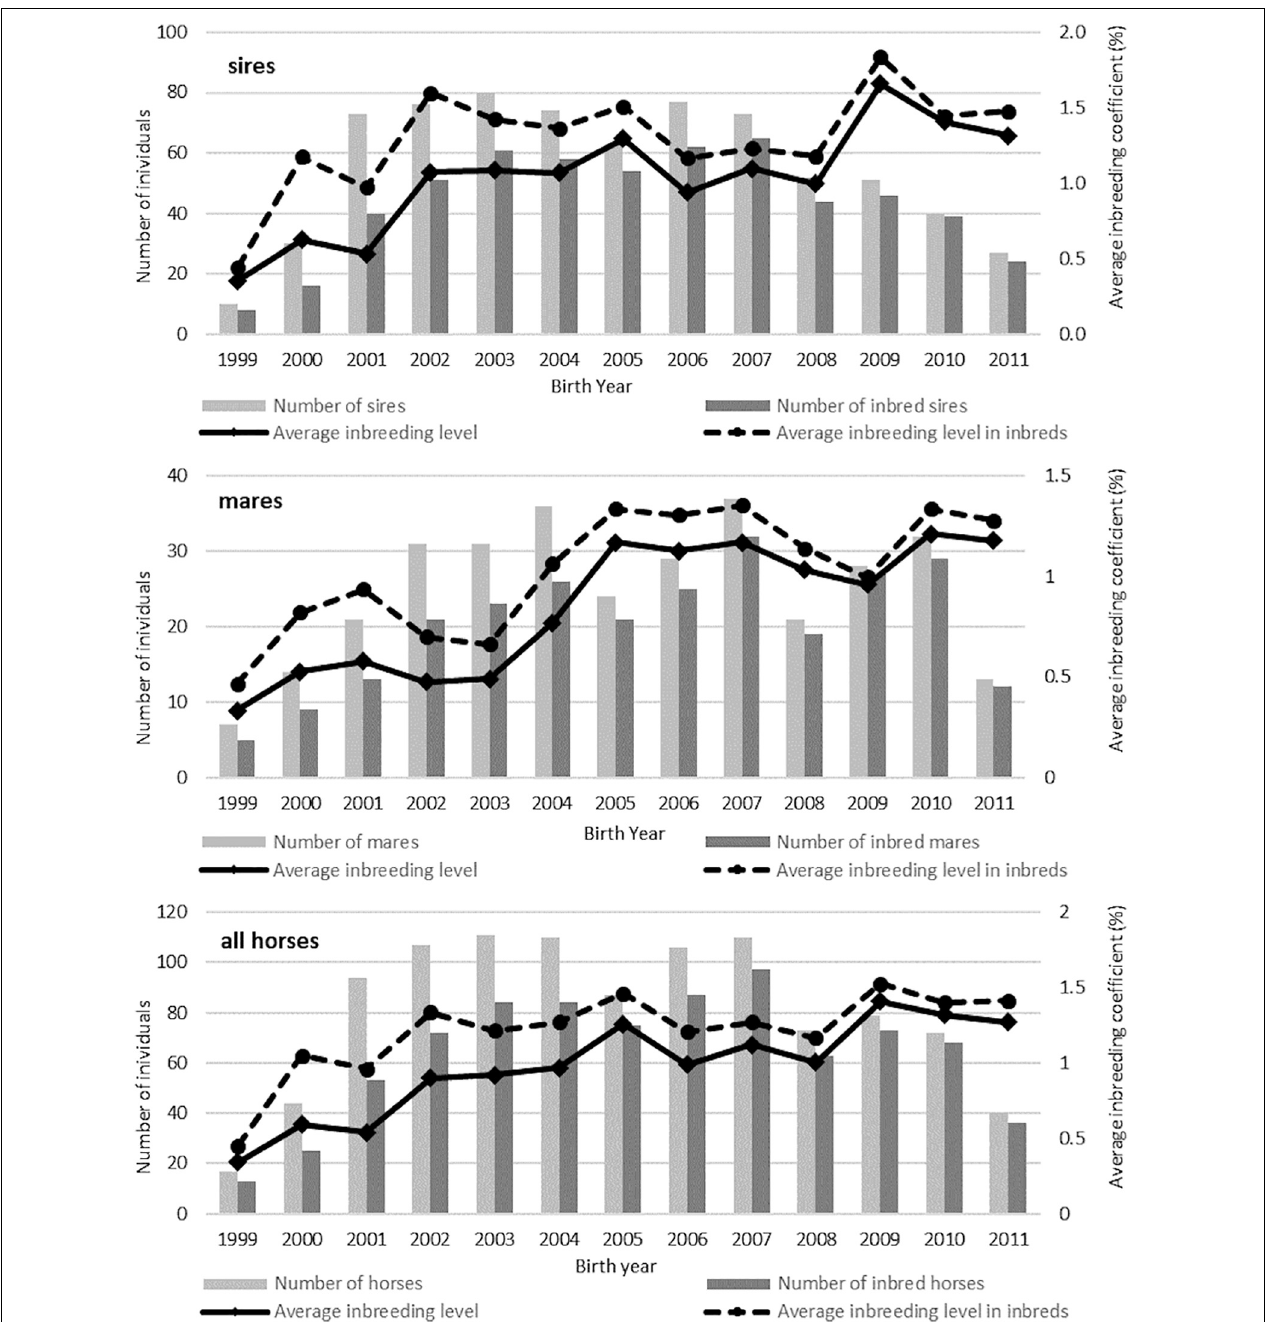
FIGURE 3 | Number of inbred horses and the average inbreeding coefficients (F%) in consecutive years for sires, mares, and all horses.